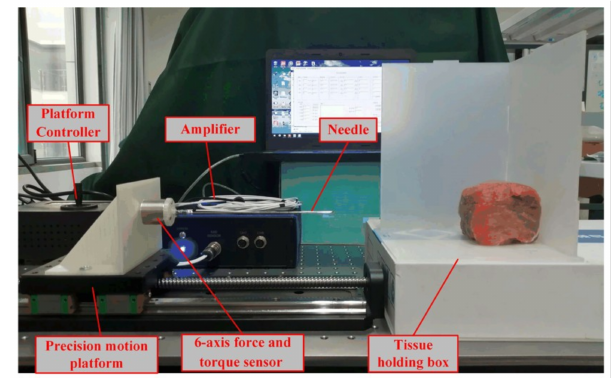
Figure 7. Device for verifying the experiments.